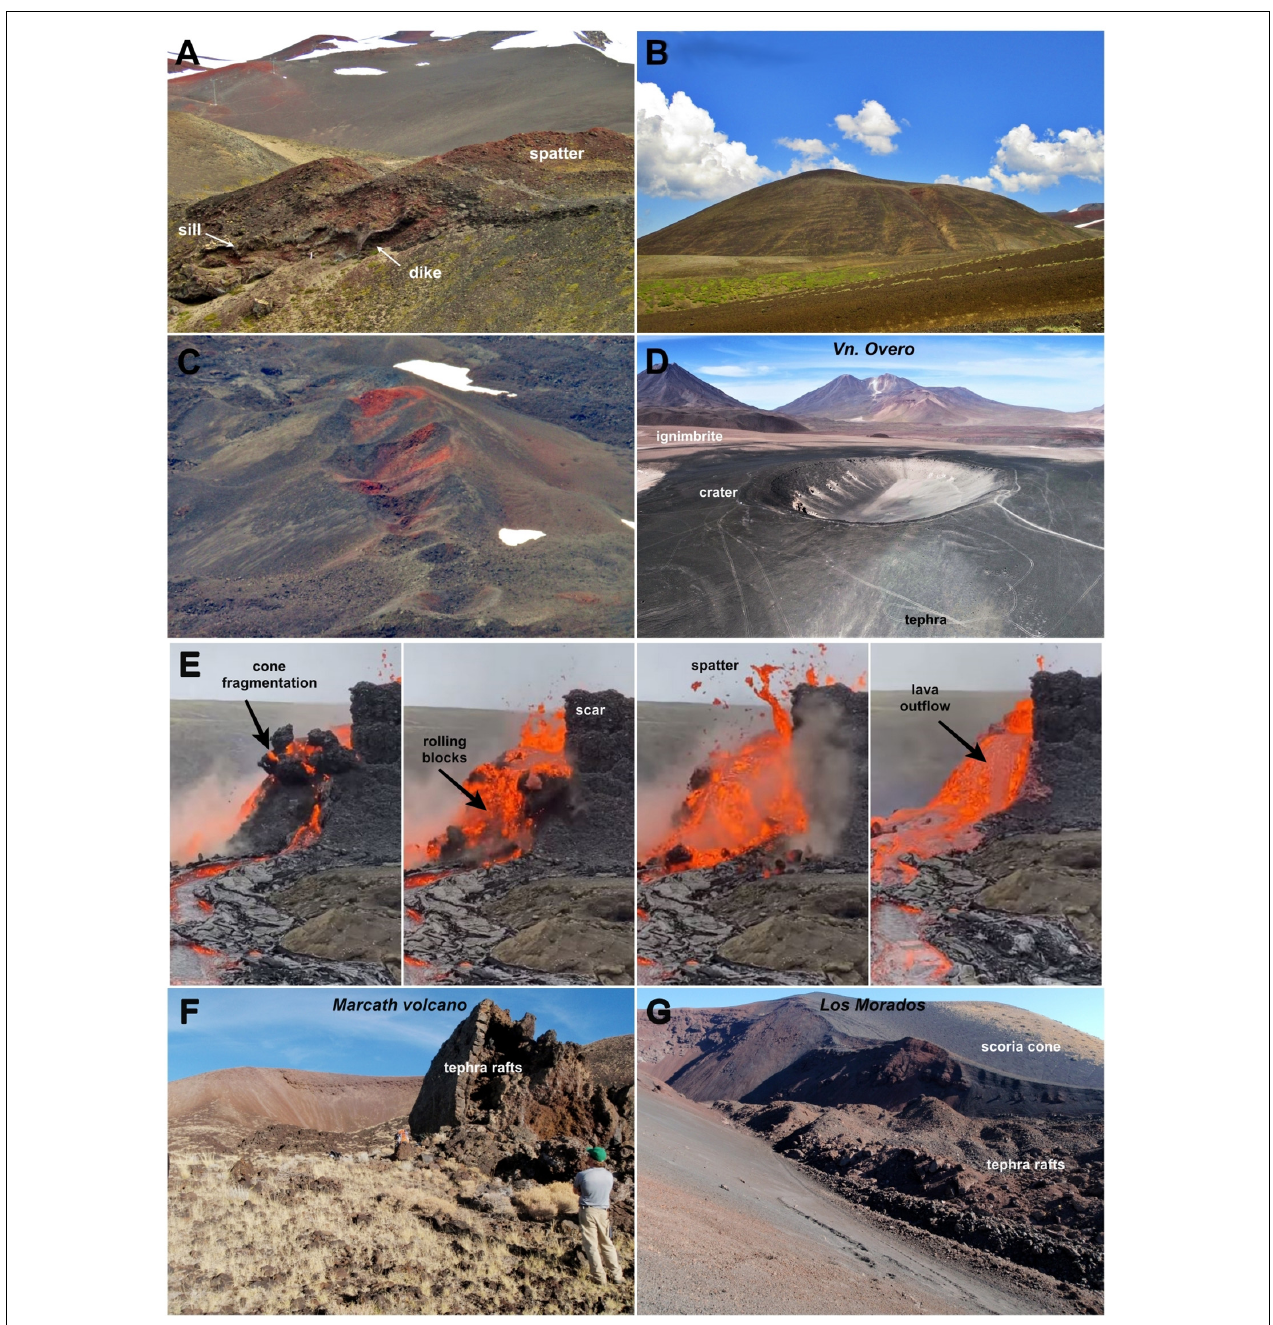
FIGURE 3 | Mafic monogenetic volcanoes. (A) Spatter Cone (Osorno volcano, Chile); (B) Scoria Cone (Villarrica, Chile); (C) volcanic fissure (Antuco, Chile); (D) Maar (Overo volcano, Chile); (E) Sequence of landslide at a spatter cone during the Geldingadalur eruption (Reykjanes Peninsula, Iceland, 2021); (F) Marcath volcano (United States) and tephra rafts. (G) Los Morados cone (Argentina) and tephra rafts. Photos (A – C) by Jorge Romero. Photos (D – G) by Gabriel Ureta, Bini Smári, G.A. Vallentine.